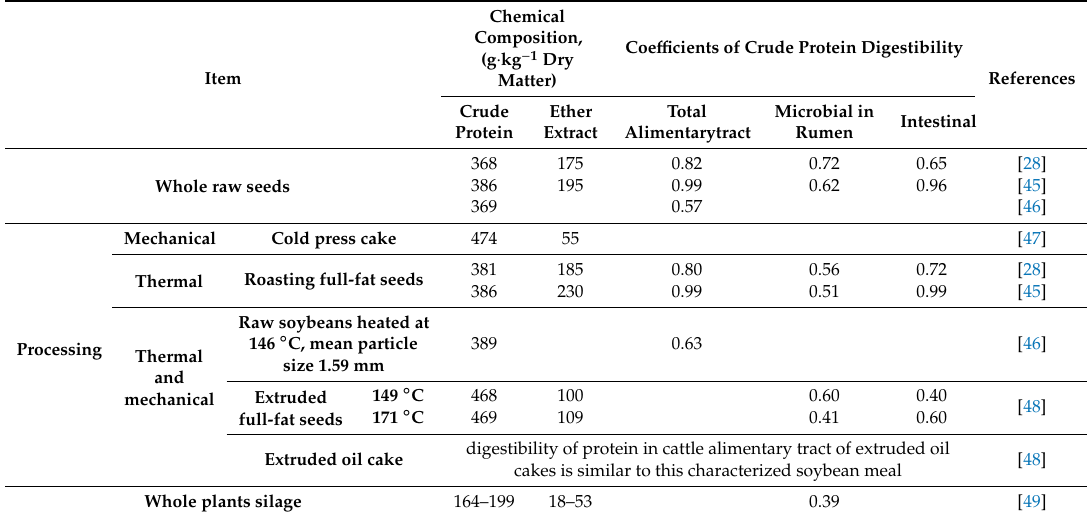
Table 2. The e ff ects of processing methods of soybean on the digestibility of protein in cattle alimentary